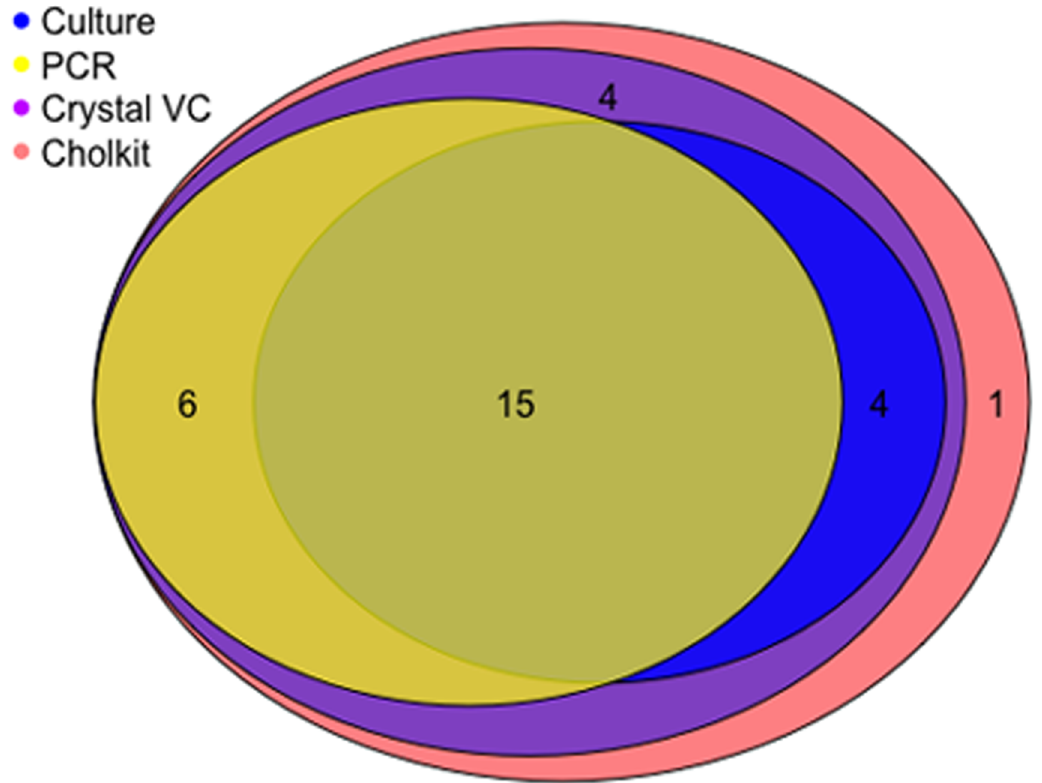
Fig 3. Euler diagram that illustrates overlap of the positive test results from four diagnostic tests analyzed in the Bayesian latent class modeling.